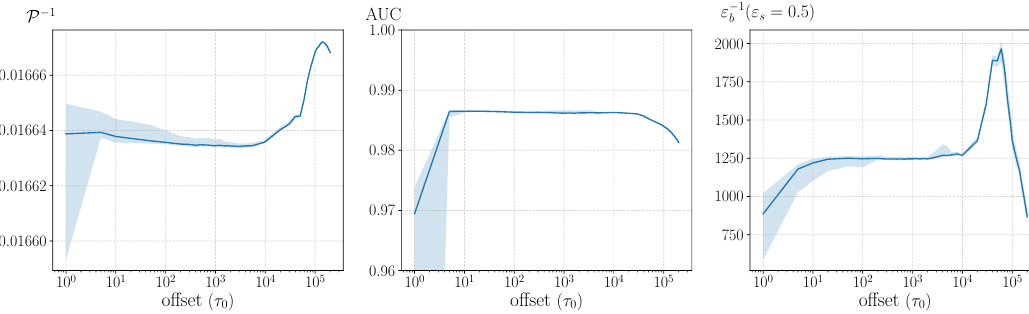
Figure 18 . The inverse perplexity (left), AUC (center), and inverse mistag rate (right) as functions of the o(cid:11)set for an event sample with 10 4 events and a chunk size equal to the size of the event sample. The calculations were done for 100 di(cid:11)erent random seeds, the blue lines show the mean of these and the shaded regions cover the upper and lower standard deviations. Separate upper and lower standard deviations are used to show how the actual variances in the performance statistics are typically skewed heavily towards the negative